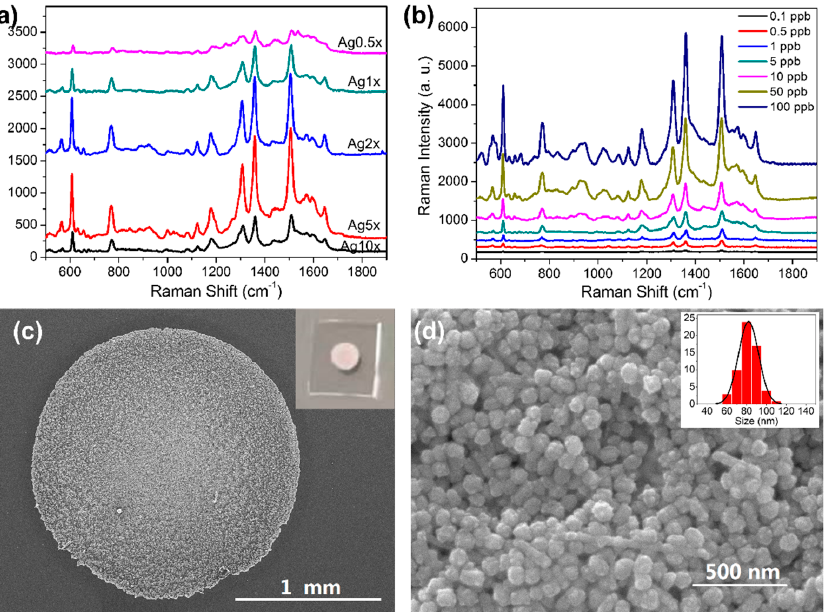
Figure 2. SERS spectra of R6G on AgNPs-PDMS substrates with various surface densities of AgNPs ( a ). SERS spectra of R6G (0.1~100 μ g L − 1 ) on optimized AgNPs-PDMS substrate ( b ). SEM images of the optimized AgNPs-PDMS substrate under different scales ( c , d ). Inset of c : photo of the prepared substrate. Inset of d : statistical analysis of size distribution of the modified AgNPs.